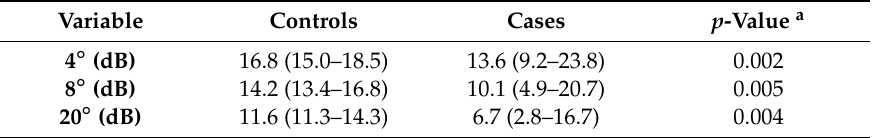
Table 3. Di ff erences in retinal sensitivity parameters between cases and controls expressed as median and interquartile range